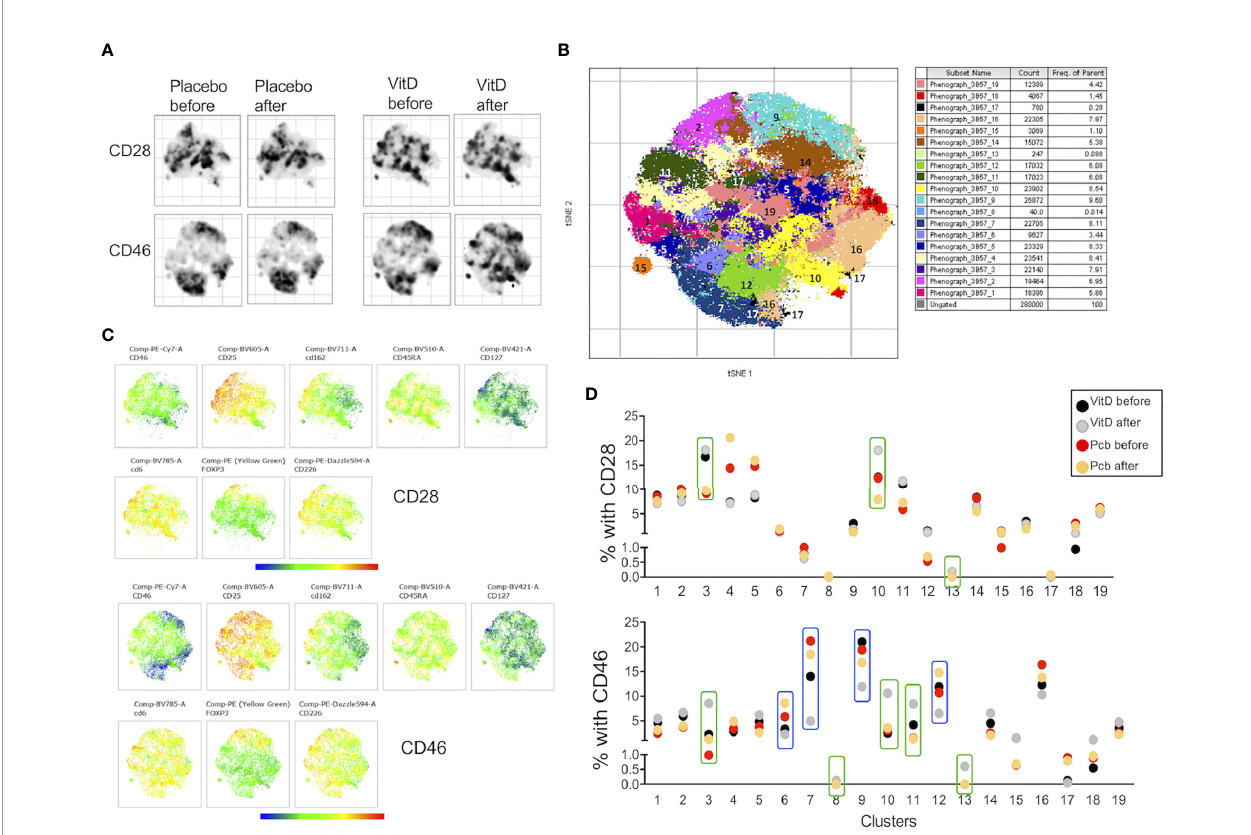
FIGURE 8 | Vitamin D supplementation modulates the phenotype of T cells in patients with multiple sclerosis (MS) after in vitro activation. (A) t-SNE representation and (B) intensity of staining of CD46, CD25, CD162, CD45RA, CD127, CD6, Foxp3, and CD226 in CD3+CD4+ T cell clusters after CD28 or CD46 costimulation of PMBCs from patients with MS supplemented by vitamin D or placebo (n=3 and n=4, respectively). (C) visualization of clusters identi fi ed by Phenograph on t-SNE- map analysis of the CD3+CD4+ T cells. (D) Percentage of the 19 clusters identi fi ed by PhenoGraph in the vitamin D and placebo groups before and after treatment. Clusters increased (green boxes) or decreased (blue boxes) after vitamin D supplementation are